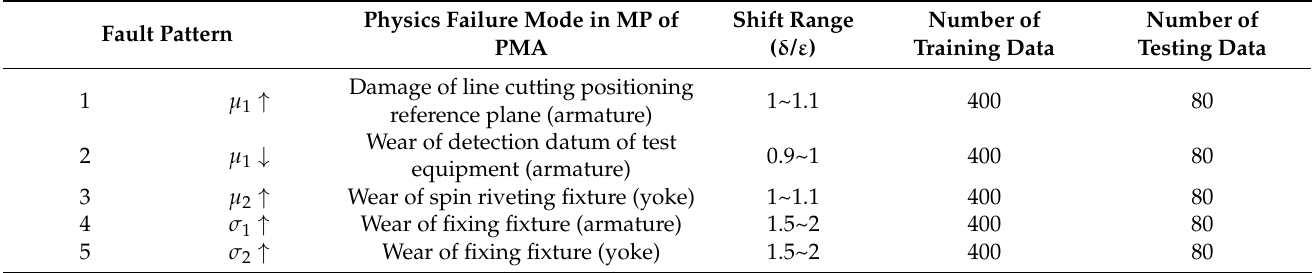
Table 4. Fault pattern and related parameters. (“ ↑ ” means increase, “ ↓ ” means decrease).